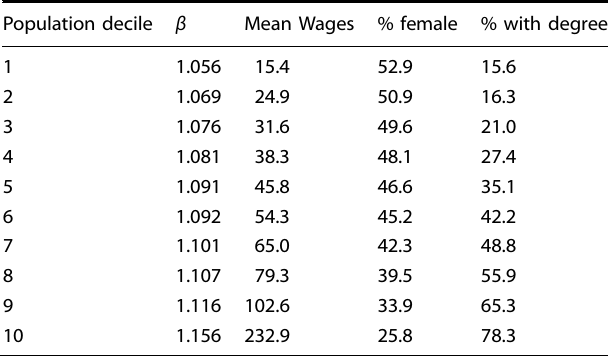
Table 1. 2019 power-law scaling exponents for MSA decile total wages vs. MSA size, with mean annual decile wages and other select attributes (wages in thousands of